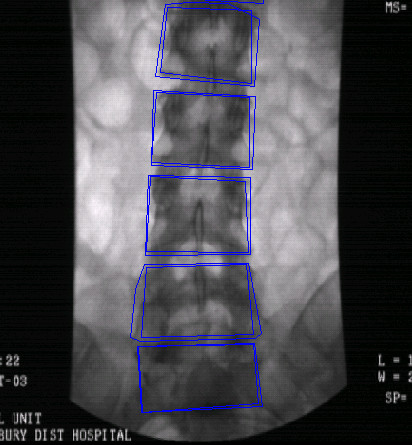
First digital image in a side bending sequence, cursor-marked with external (tracking) and internal (visual) templates.